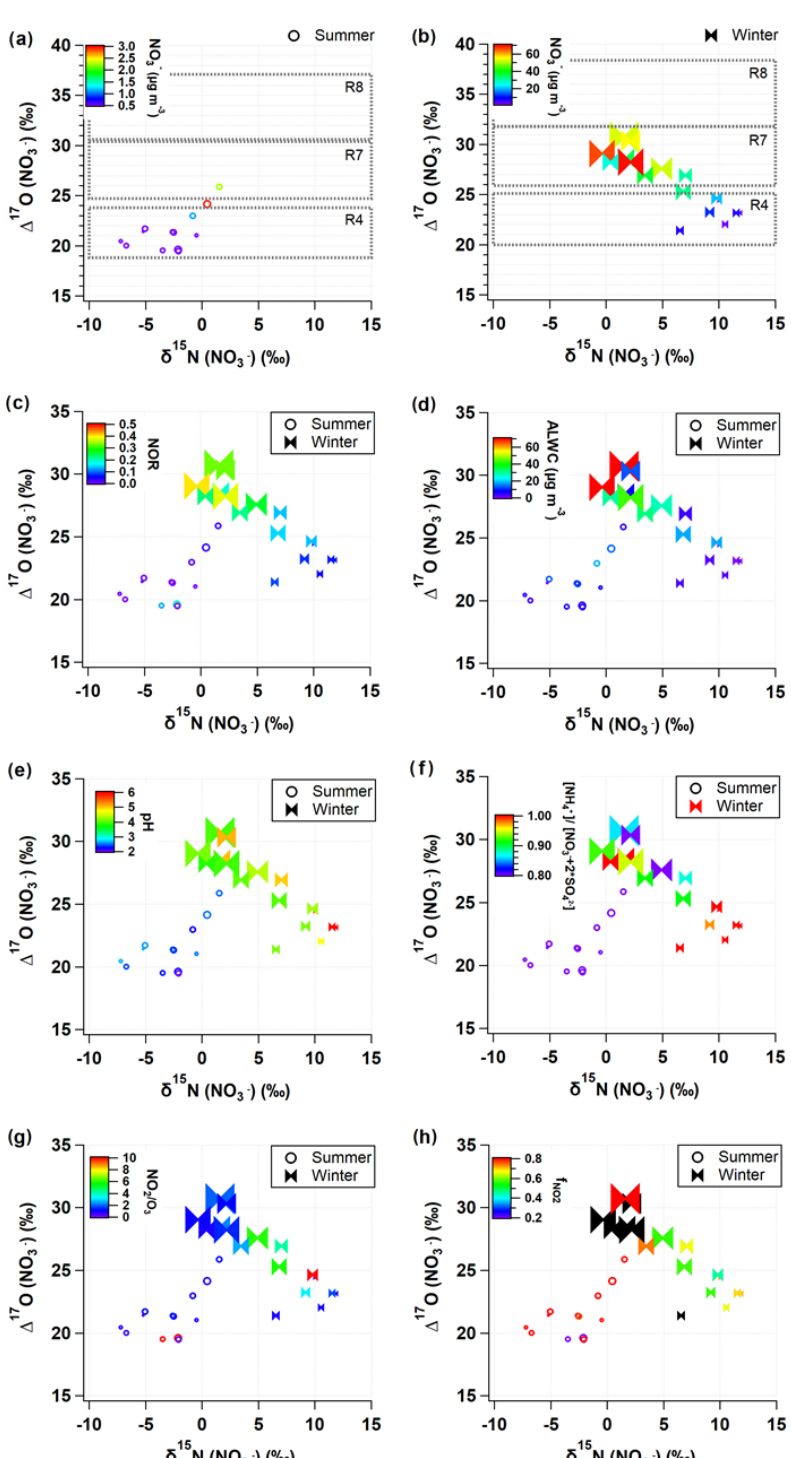
− ) and (cid:49) 17 O (NO − ) values with key parameters during the summer (open circle) and 3 3 ) values are presented as dotted rectangles for the three major NO − 3 ] / ( [ SO 2 − ]+[ NO − ] ) equivalent ratio, (g) NO 2 / O 3 ratio, and (h) f NO 2 . Marker size is proportional 4 4 3